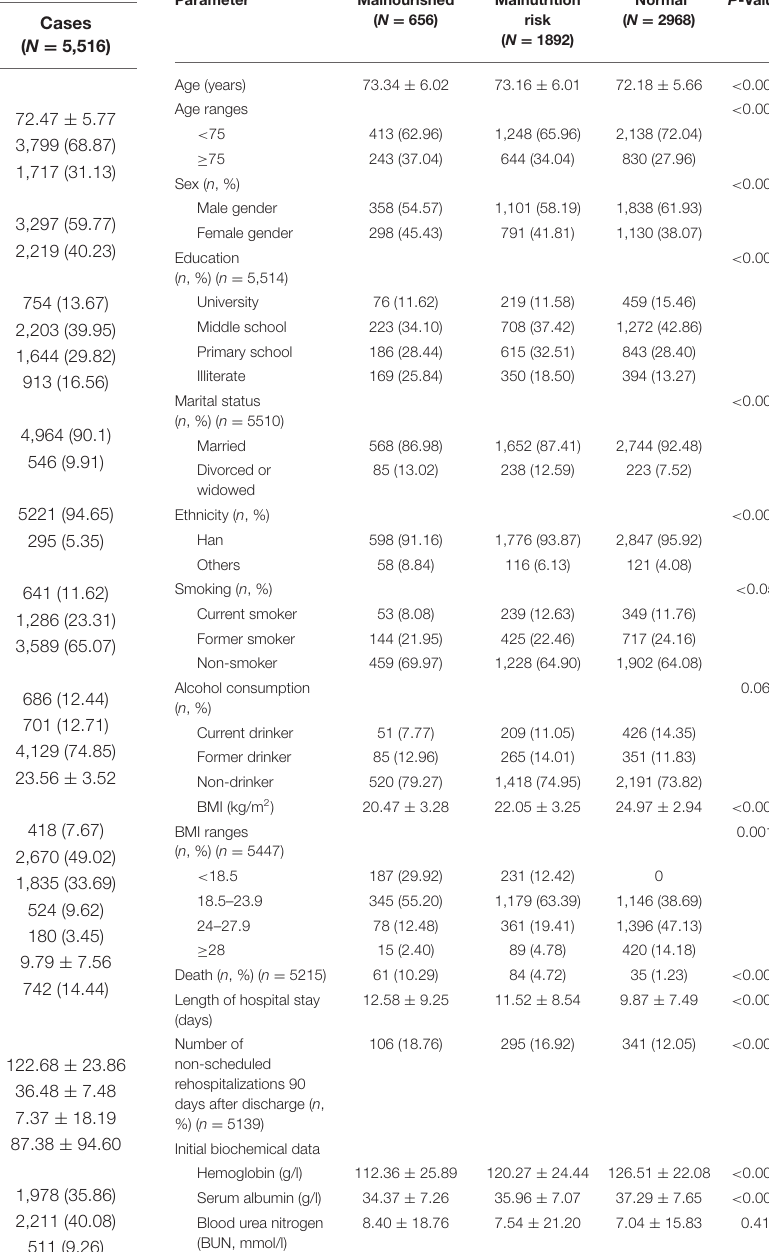
TABLE 1 | Demographic and clinical characteristics of patients in relation to MNA-SF score on admission. Parameter Cases